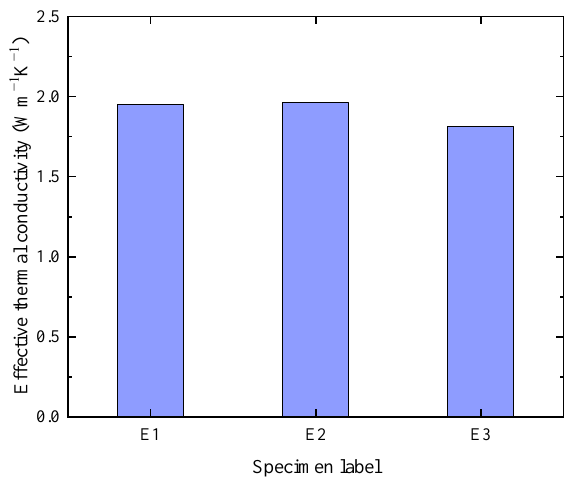
Figure 14. Effect of air void distribution on asphalt concrete thermal conductivity.